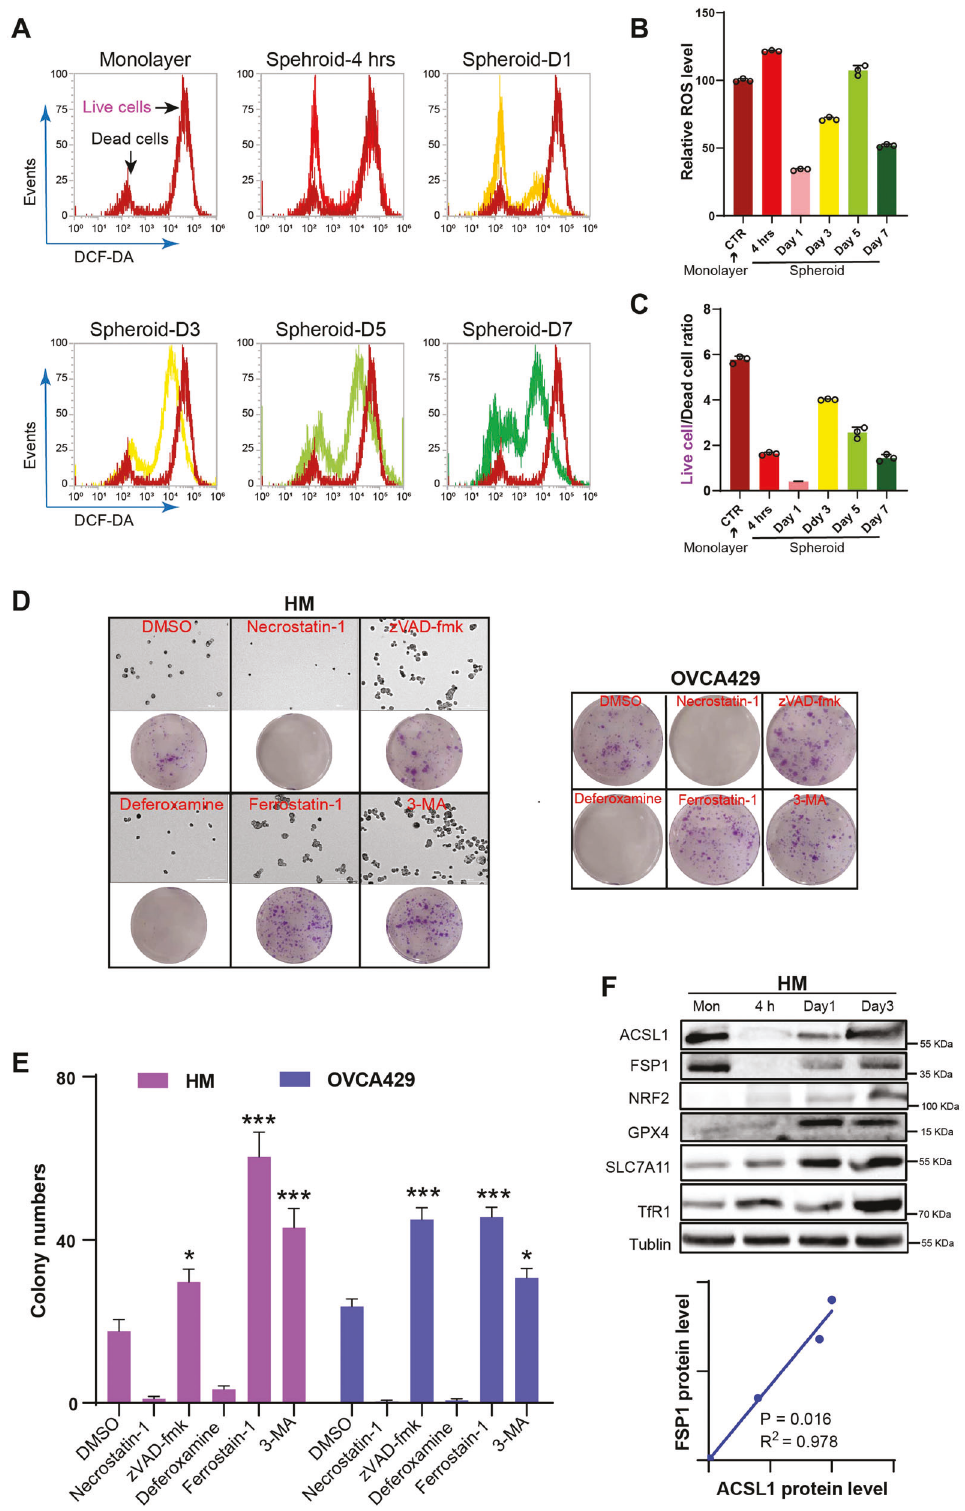
acid into cell phospholipids [13]. Our recent study suggested that ACSL1 and ACSL3 protein levels are signi fi cantly up-regulated in the highly metastatic ovarian cancer cell lines and their gene expressions are correlated with metastatic capacity and poor survival prognosis [14]. ACSL1 overexpression signi fi cantly